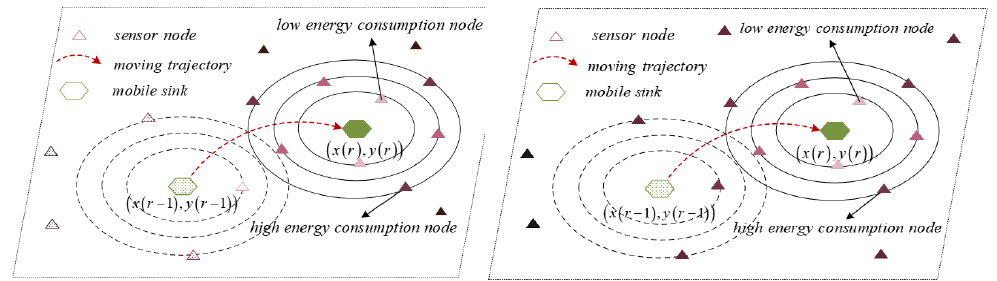
Figure 5. Energy intensity distribution.